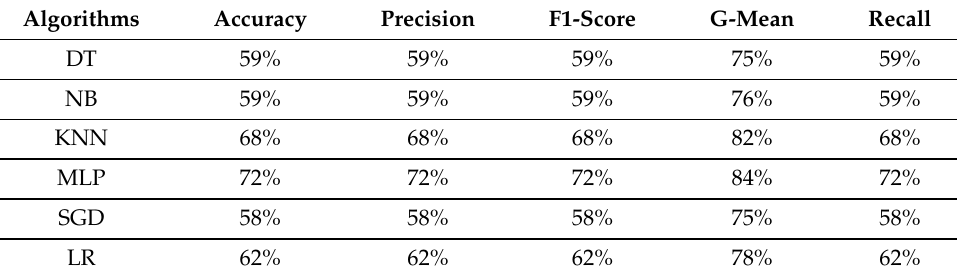
Table 3. Score values of the various measures for each algorithm for the BDD100K